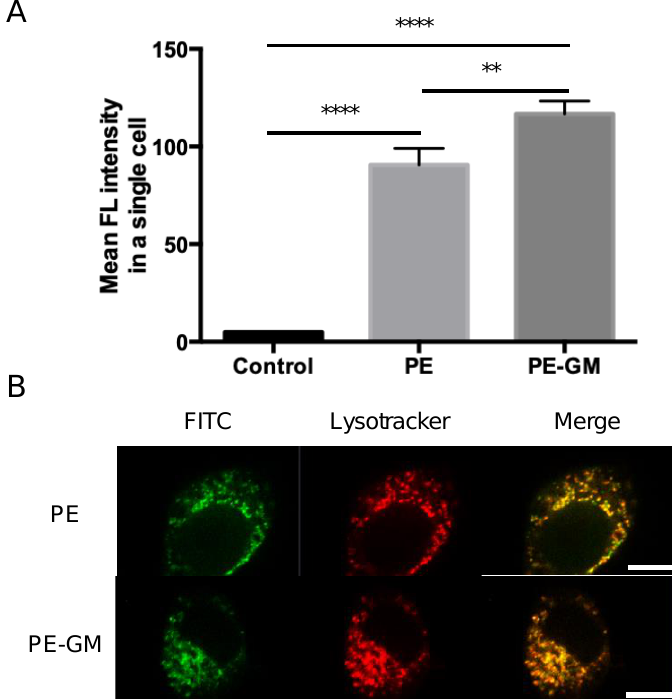
Figure 4. ( A ) Comparison of the mean fluorescent intensity of non-treated cells (control), cells treated with FITC-labeled PE, and PE-GM. ( B ) Confocal images of dendritic cells (DCs) treated with FITC labeled PE and PE-GM. Lysosomes at DCs were stained with Lysotracker (red). Bars: 10 μm. n = 3, mean ± SE. ** p < 0.01, **** p < 0.0001.